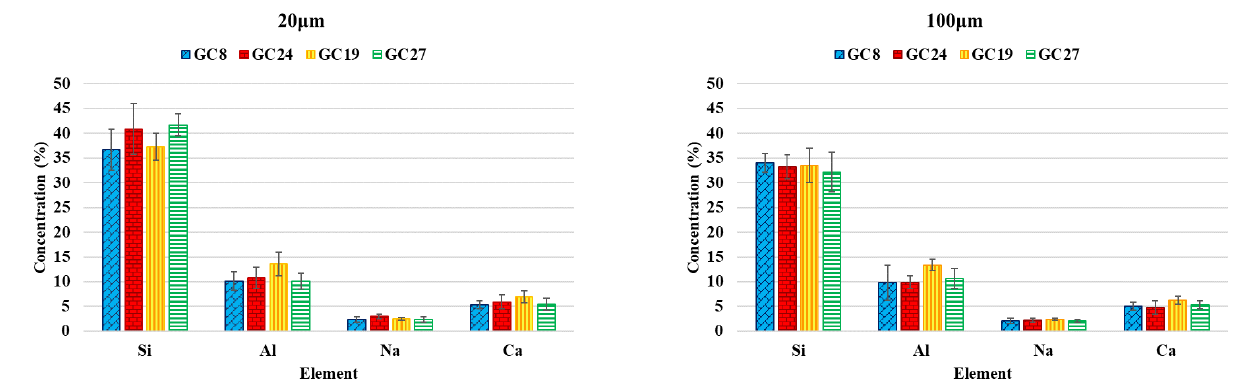
Figure 11. SEM-EDX elemental analysis at 20 μm and 100 μm bands.